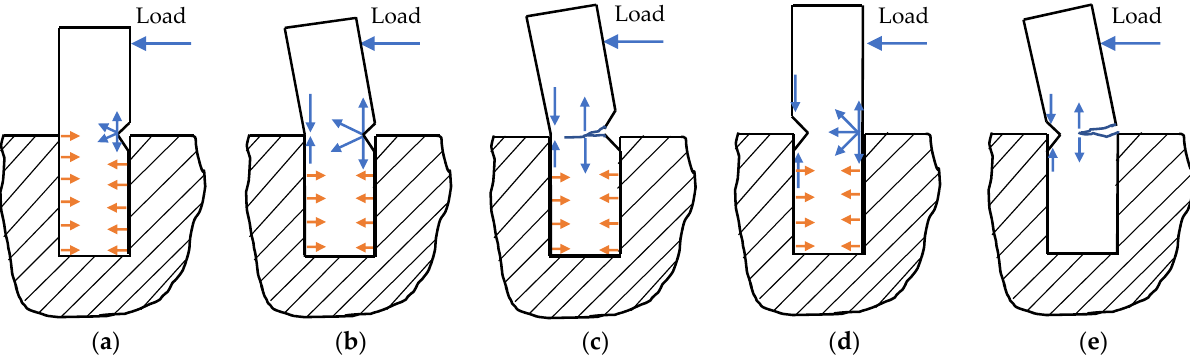
Figure 7. A schematic demonstration of specimen failure in notched Izod impact test ( a – c ) and unnotched Izod impact test ( d – e ).